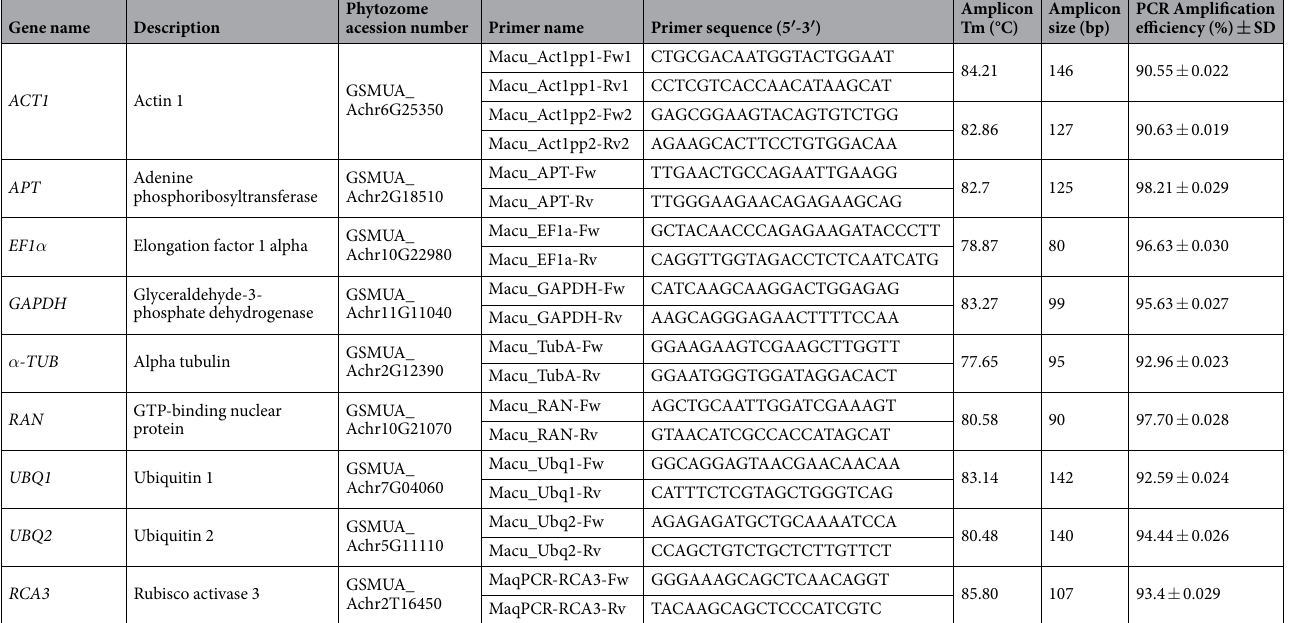
Table 1. Candidate reference genes and target gene for Musa acuminata leaf tissues, primer sequences and RT- qPCR